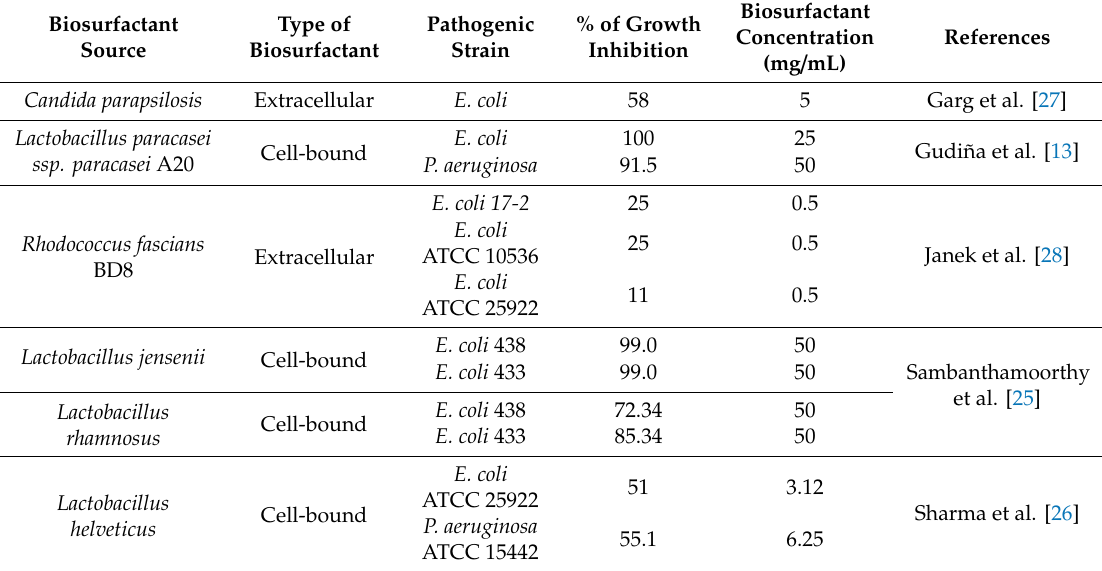
Table 1. Comparison of antimicrobial activity of di ff erent biosurfactants from the literature against P. aeruginosa and E. coli expressed in percentages of growth inhibition (PBS—Phosphate bu ff er saline; PB—Phosphate bu ff